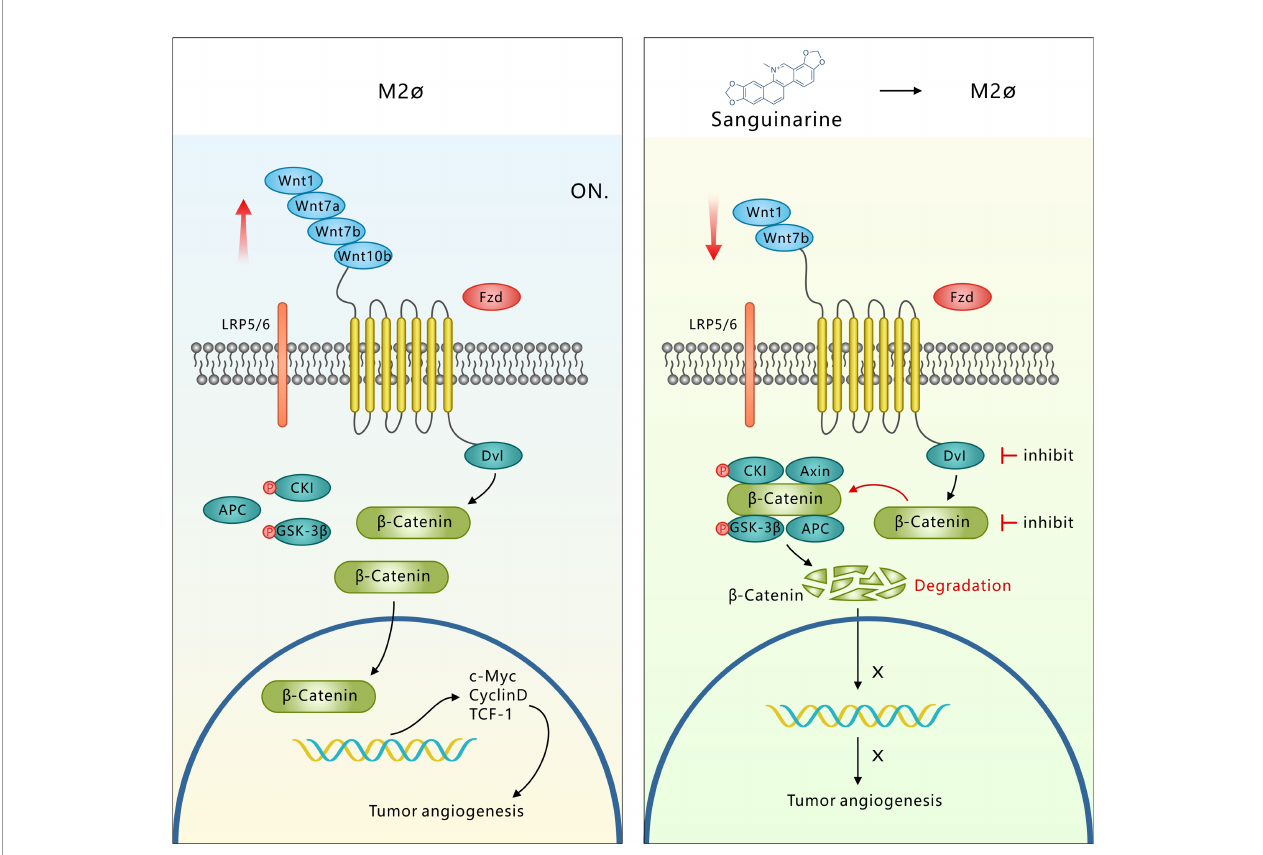
FIGURE 7 | Sang targets the WNT/ b -Catenin signaling pathway in TAMs, which represses M2 polarization and thus inhibits TAM-mediated neoangiogenesis. M2- like TAMs show upregulation of WNT ligands (1-7a-7b-10b), leading to transcriptional activation of b -Catenin. b -Catenin translocation into the nucleus induces M2 macrophage polarization, which further promotes the secretion of VEGF protein in HUVECs, leading to the initiation of tumor angiogenesis. However, Sang inhibited WNT/ b -Catenin signaling in M2 TAMs by downregulating ligands ( 1-7b ) and degrading b -Catenin. b -Catenin could not enter the nucleus to induce M2 macrophage polarization, which thus restrained the secretion of VEGF protein in HUVECs and ultimately suppressed tumor angiogenesis and tumor